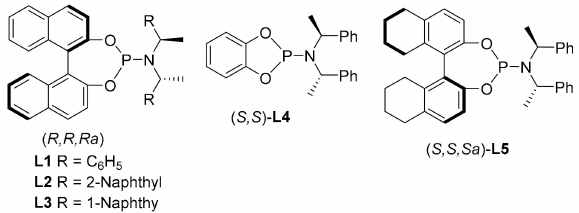
Figure 1. Ligands used in this reaction. Having established the optimal reaction conditions shown in the entry 12 of Table 1, we further surveyed the scope of various allylic substrates 2 . When 2a and substrates 2b – 2c , 2e – 2h having an electron-rich substituent (e.g., p -Et, p - iso -Propyl, p -MeO, m -Me, m -MeO, and m -EtO) on the phenyl ring were employed, the corresponding 3a – 3c , 3e – 3h were obtained in moderate to good yields with high regio- and enantioselectivities. Screening reaction conditions for Ir-catalyzed reaction between